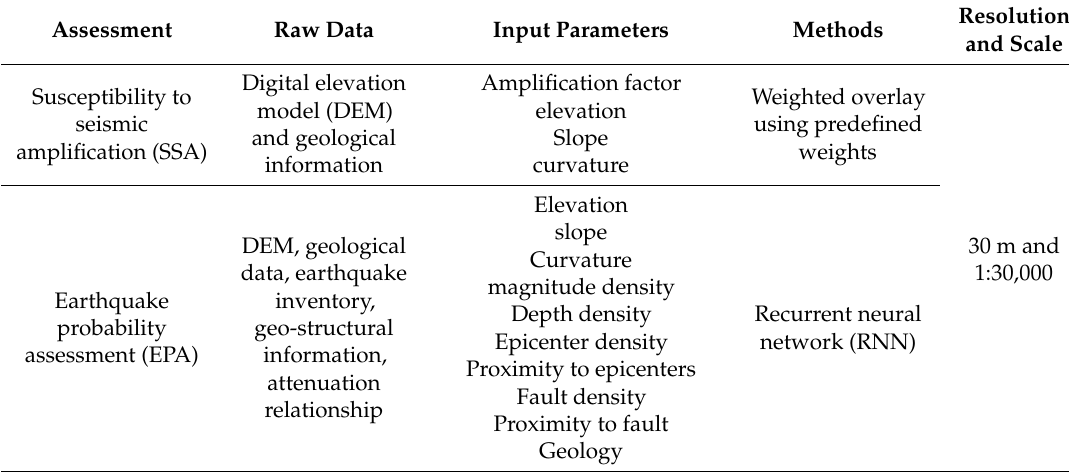
Table 1. Raw data and input parameters used for